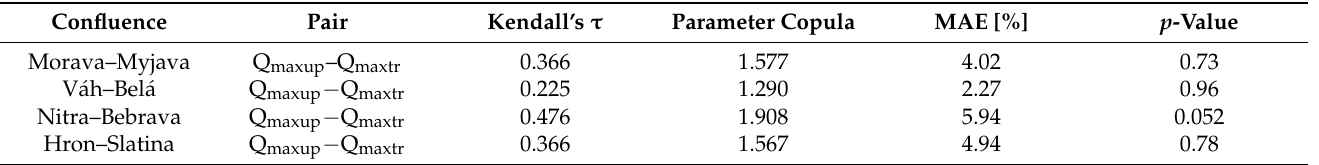
Table 4. The Gumbel–Hougaard copula parameters for the selected variable combinations, mean absolute errors (MAE) values, and K–S test.